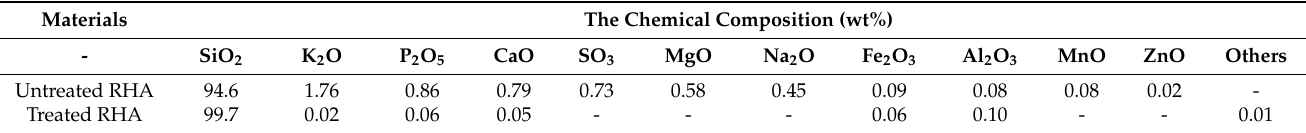
Table 2. Chemical composition of the rice husk ash.